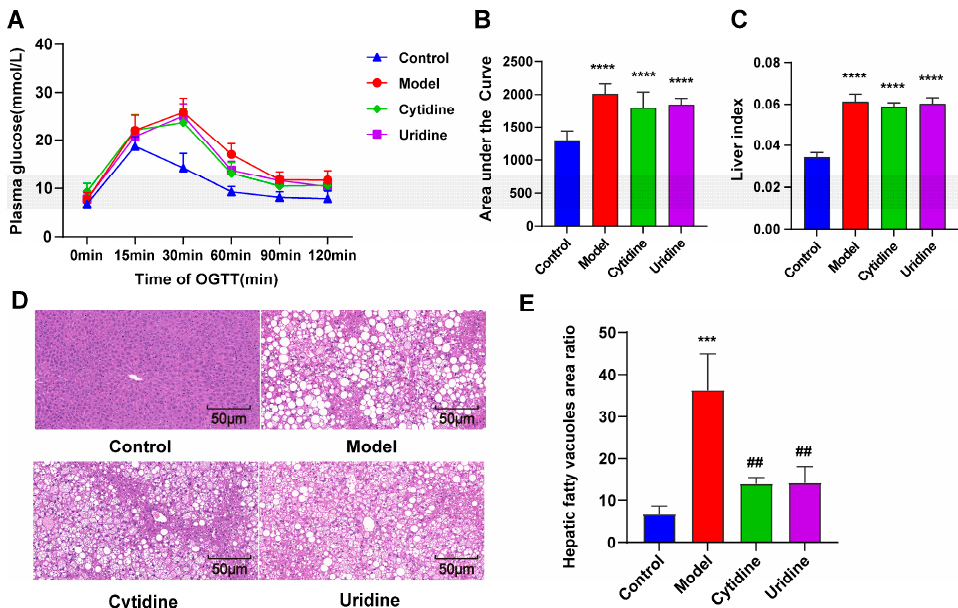
Figure 2. Effect of cytidine on oral glucose tolerance test (OGTT) ( A , B ), liver index ( C ), hepatic steatosis ( D ) and hepatic fatty vacuoles area ratio ( E ) in ob/ob mice. Data are expressed as mean ± SD (n = 8). *** p < 0.001, **** p < 0.0001 compared with control group; ## p < 0.01 compared with model group.